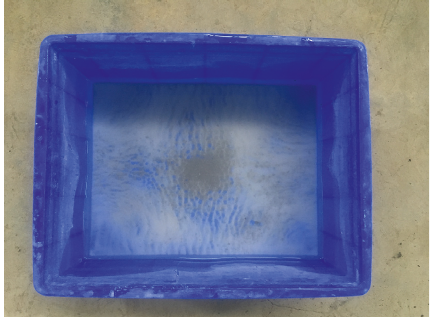
Figure 13: The phenomenon of Ca(OH)